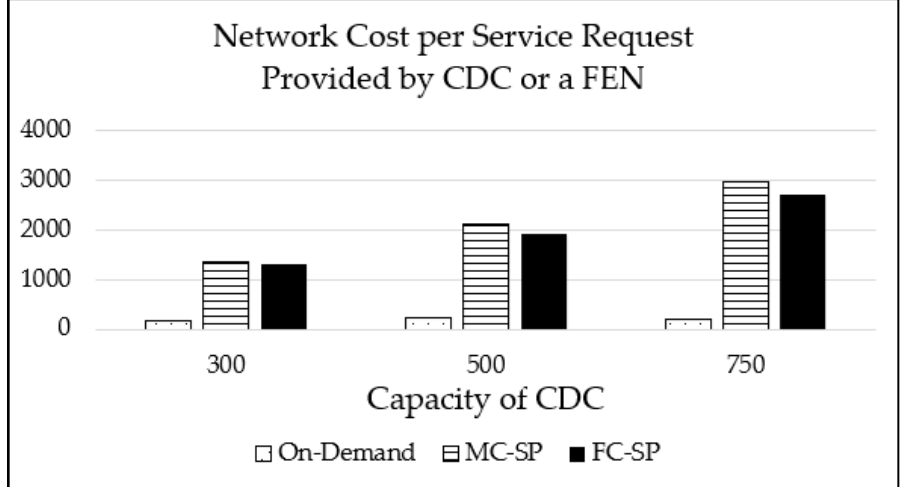
Figure 10. The network cost per service request for various maximum CDC capacities with 1000 service types for the L distribution case.